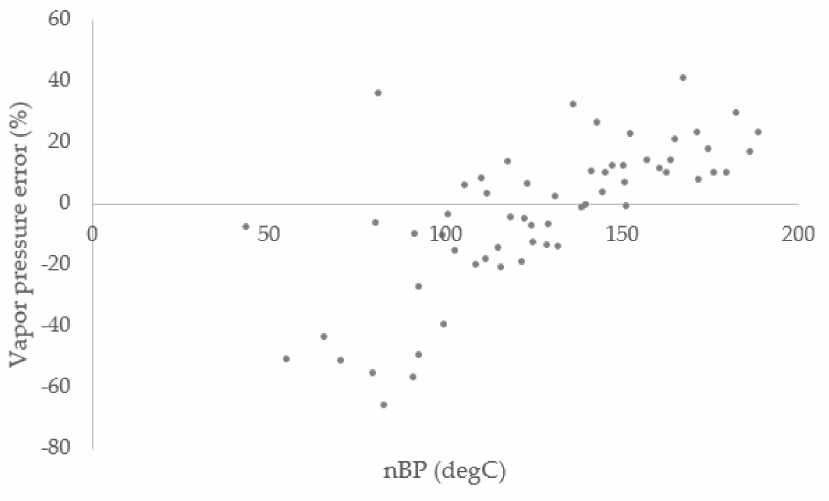
Figure 2. Percent error of the vapor pressure calculated using PC-SAFT for all gasoline fractions analyzed in this work.